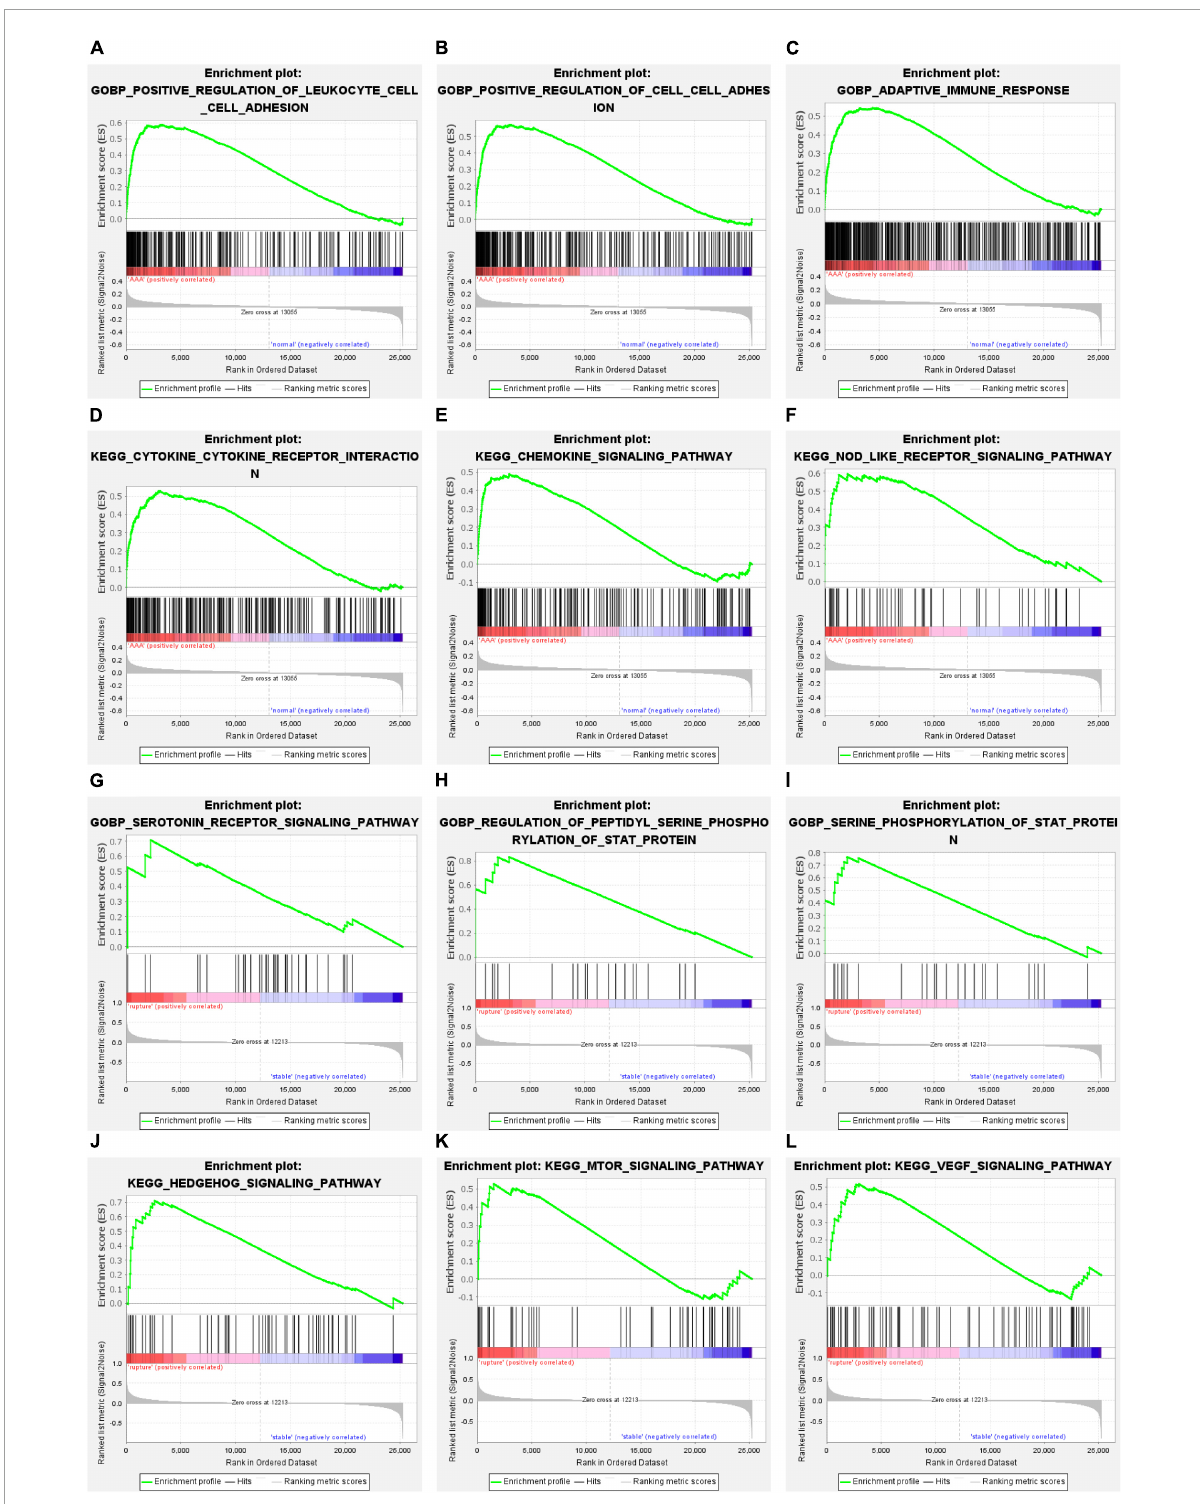
FIGURE3 The results of GSEA. (A–C) The GO-BP terms significantly enriched in AAA group. (D–F) The KEGG pathways significantly enriched in AAA group. (G–I) The GO-BP terms significantly enriched in aortic rupture group. (J–L) The KEGG pathways significantly enriched in aortic rupture group. GSEA, gene set enrichment analysis; GO-BP, Gene Ontology-biological process; AAA, abdominal aortic aneurysm; KEGG, Kyoto Encyclopedia of Genes and